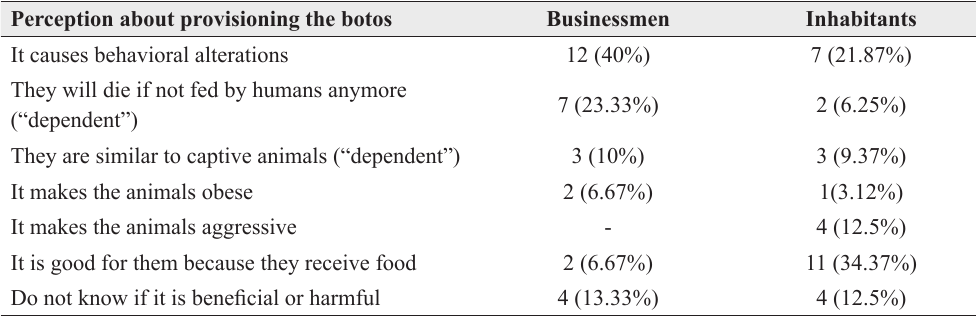
Interference of the activity of provisioning specifically on the botos involved, according to the businessmen and inhabitants from Novo Airão.